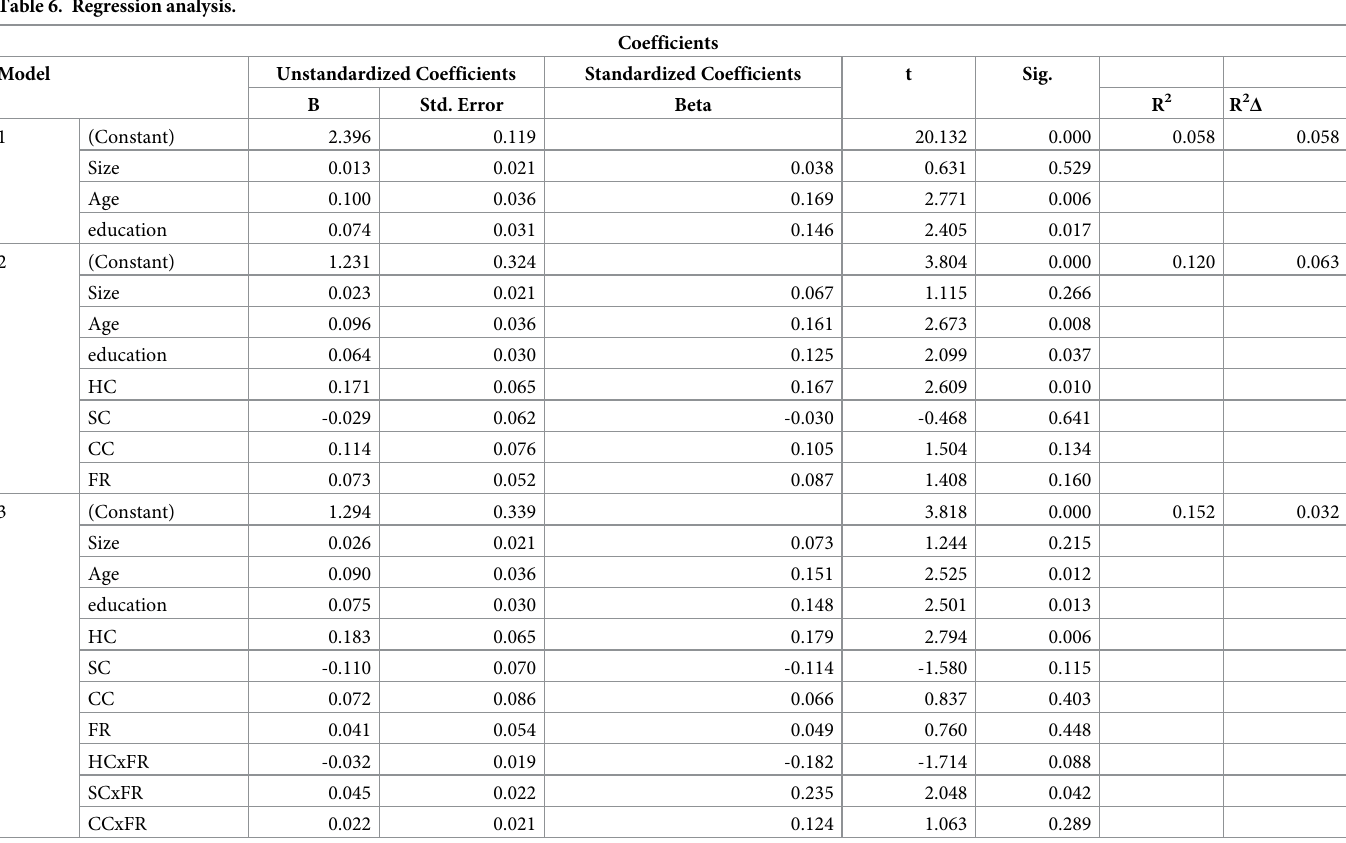
Table 6. Regression